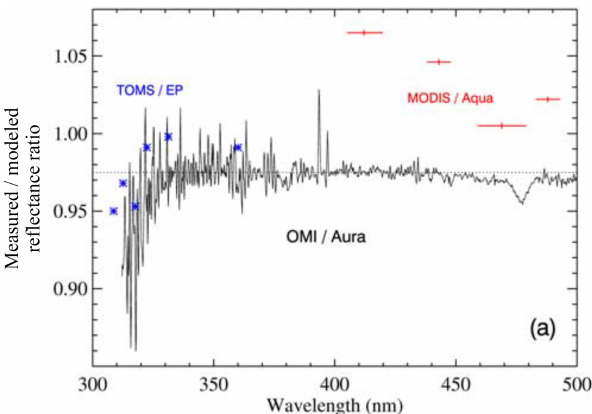
Figure D1. The mean ratios of TOA satellite reflectances to a model used over Antarctica for validation during the 2004 solstice; OMI (solid line), MODIS (red bars), and TOMS/Earth Probe (asterisks). Data shown are for the interval 62 ◦ ≤ θ 0 ≤ 68 ◦ (47 ◦ ≤ θ 0 ≤ 52 ◦ for TOMS/Earth Probe). Uncertainties on MODIS bands other than band 3 (470nm) are estimated to be several percent. Reproduced from Fig. 9a of Jaross and Warner